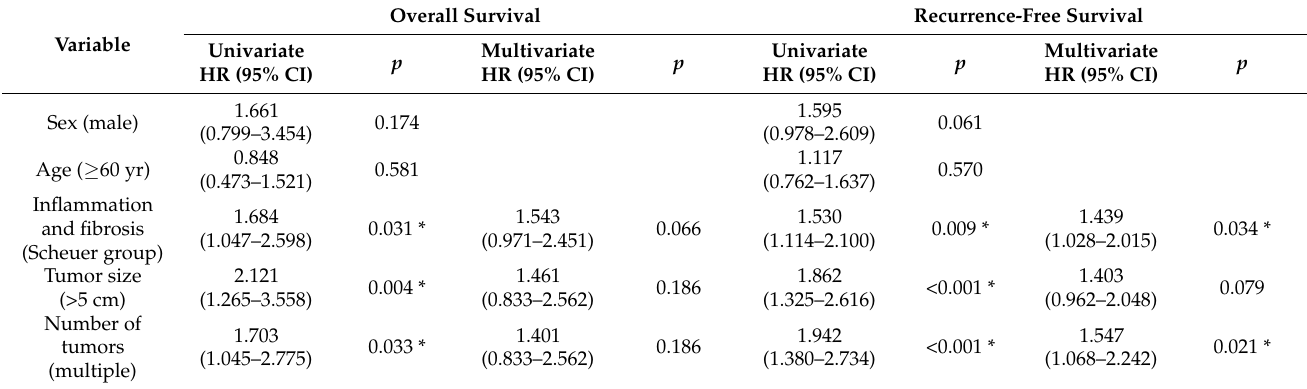
Figure 1. The prognostic significance of the inflammation and fibrosis. ( A , B ) Before propensity score match, recurrence-free survival ( A ) and overall survival ( B ) of non-cirrhotic HBV-associated HCC patients after hepatectomy. ( C , D ) After propensity score match, recurrence-free survival ( C ) and overall survival ( D ) of non-cirrhotic HBV-associated HCC patients after hepatectomy. Patients were stratified based on the Scheuer system. Table 4. Uni- and multivariate analyses to identify predictors of recurrence-free and overall post- hepatectomy survival of patients with non-cirrhotic HBV-associated HCC, before propensity score